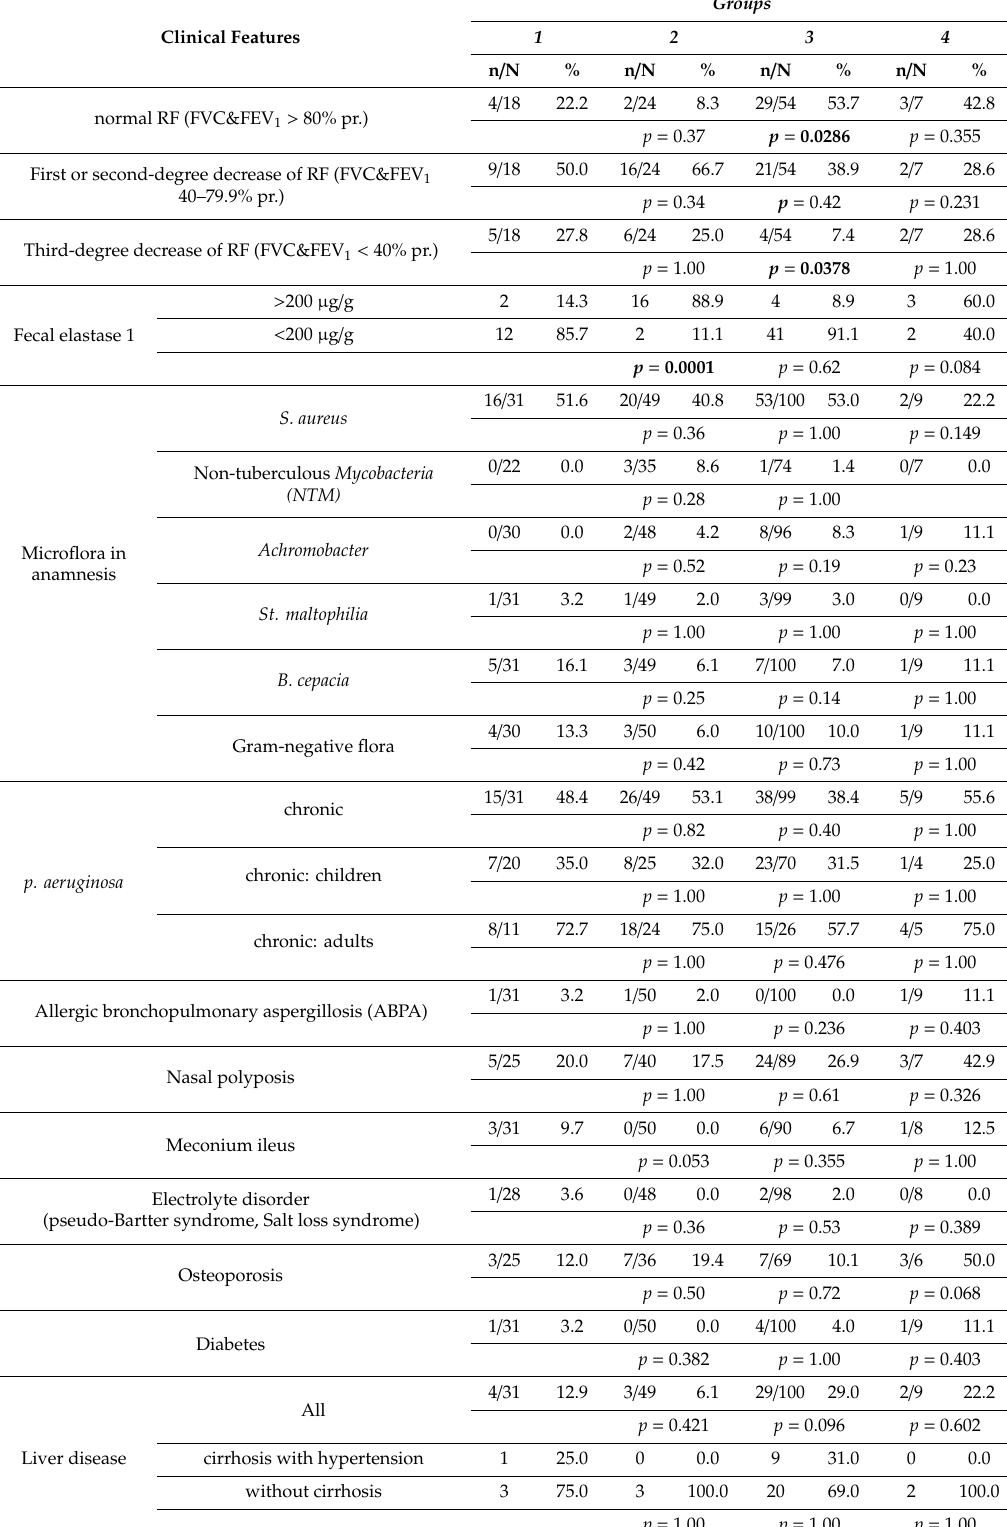
Table 4. Clinical characteristics of CF patients with various